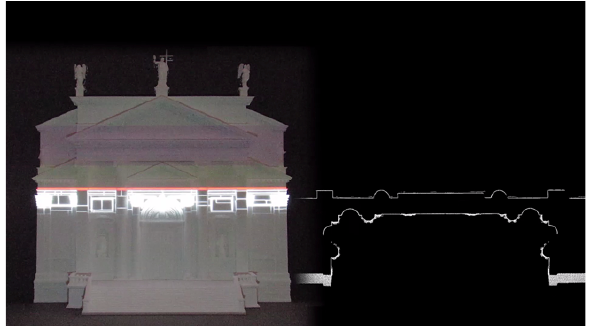
Figure 6. Screenshot of the simultaneous sections controlled by Leap Motion sensor. The red line on the left shows the cutting position. The image on the right is showing the changing section.